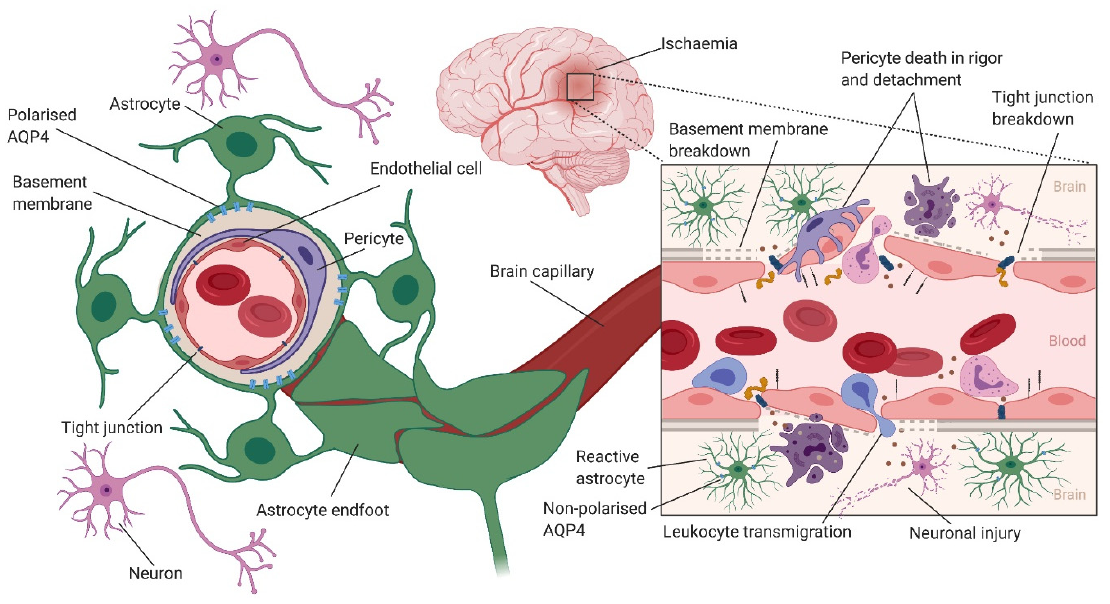
Figure 2. Blood–brain barrier (BBB) dysfunction following ischaemic stroke. (1) Simplified structure of the neurovascular unit (NVU) comprising brain endothelial cells, astrocytes, pericytes and neurons. Brain endothelial cells form tight junctions between them that control the movement of molecules through the paracellular pathway by showing size and charge selectivity, thereby forming a selective barrier between the brain microenvironment and the systemic circulation. Pericytes partially cover the endothelial cells and are embedded in the basement membrane. They are spread discontinuously along the microvessel, and maintain the barrier properties of brain endothelial cells, regulate capillary diameter, cerebral blood flow and angiogenesis. Perivascular endfeet from multiple astrocytes ensheath endothelial cells, allowing intricate cell–cell communications to help maintain the BBB phenotype of brain endothelial cells. Astrocytes secrete soluble factors that are important for the development and maintenance of the BBB. In addition, astrocytes contribute to brain water homeostasis via aquaporin 4 (AQP4) water channels, which are expressed on the endfeet of astrocytes. (2) The schematic on the right demonstrates BBB dysfunction due to cerebral ischaemia. Loss of tissue perfusion due to ischaemic stroke leads to neuronal injury and death. This causes an increase in the release of proinflammatory mediators that activates endothelial cells, astrocytes and pericytes. The resulting neurovascular inflammation disrupts tight junctions, leading to paracellular leakage and cerebral oedema. During ischaemia, AQP4 lose their polarisation from astrocyte endfeet. A dual role is played by AQP4 in cytotoxic and vasogenic oedema, where AQP4 deficiency leads to a reduction in cytotoxic oedema and improved neurological outcomes, and vasogenic oedema is increased when AQP4 is knocked down. The activated brain endothelium attracts leukocytes, which results in increased transcytosis across the BBB and neuroinflammation. This proinflammatory environment leads to changes in astrocyte morphology: “reactive astrogliosis”. Reactive astrocytes can secrete proinflammatory mediators such as IL-1 α , IL-6 and TNF- α that cause further BBB disruption and neuronal injury. In addition, ischaemic stroke causes pericyte detachment and death in rigor, which can lead to vessel constriction and the no-reflow phenomenon. Figure created with BioRender.com.